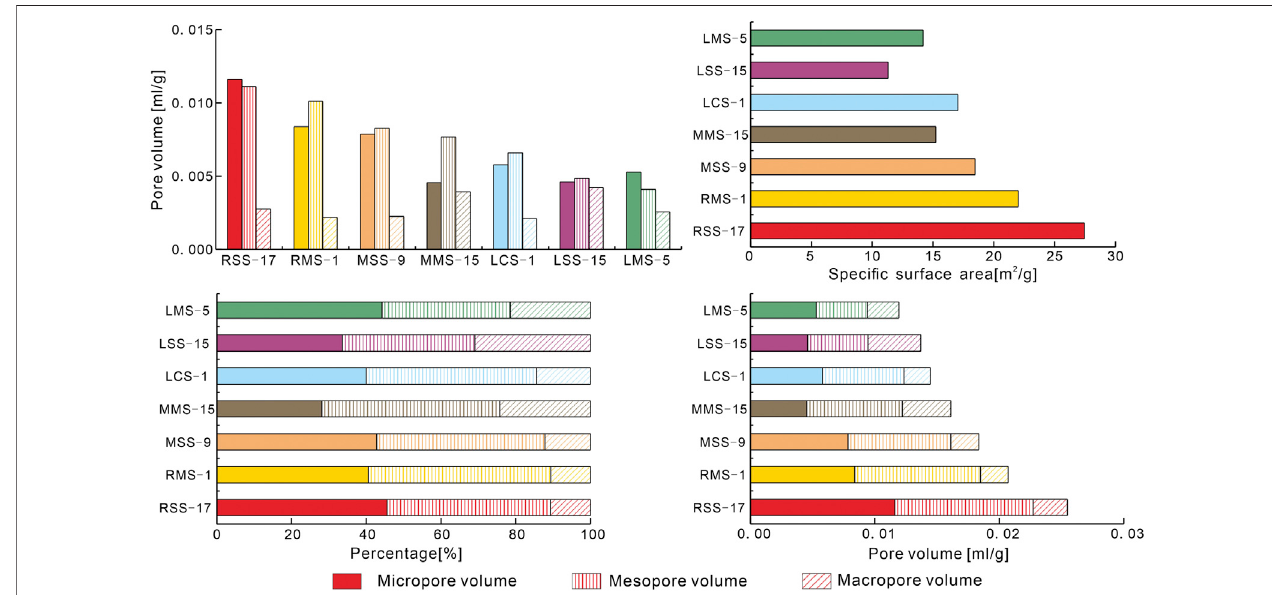
FIGURE 9 | Pore volume and speci fi c surface area distribution of derived from the combination of CO 2 GA, N 2 GA and HPMI experiments.